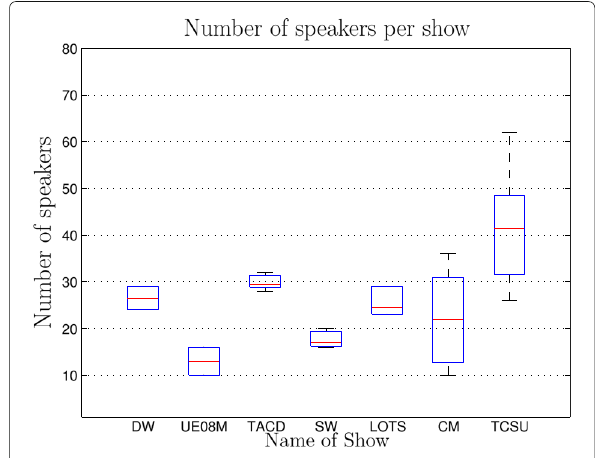
Fig. 1 Number of speakers per show. Shows DW, UE08M, TACD, SW, and LOTS correspond to development set. CM and TCSU shows belong to evaluation